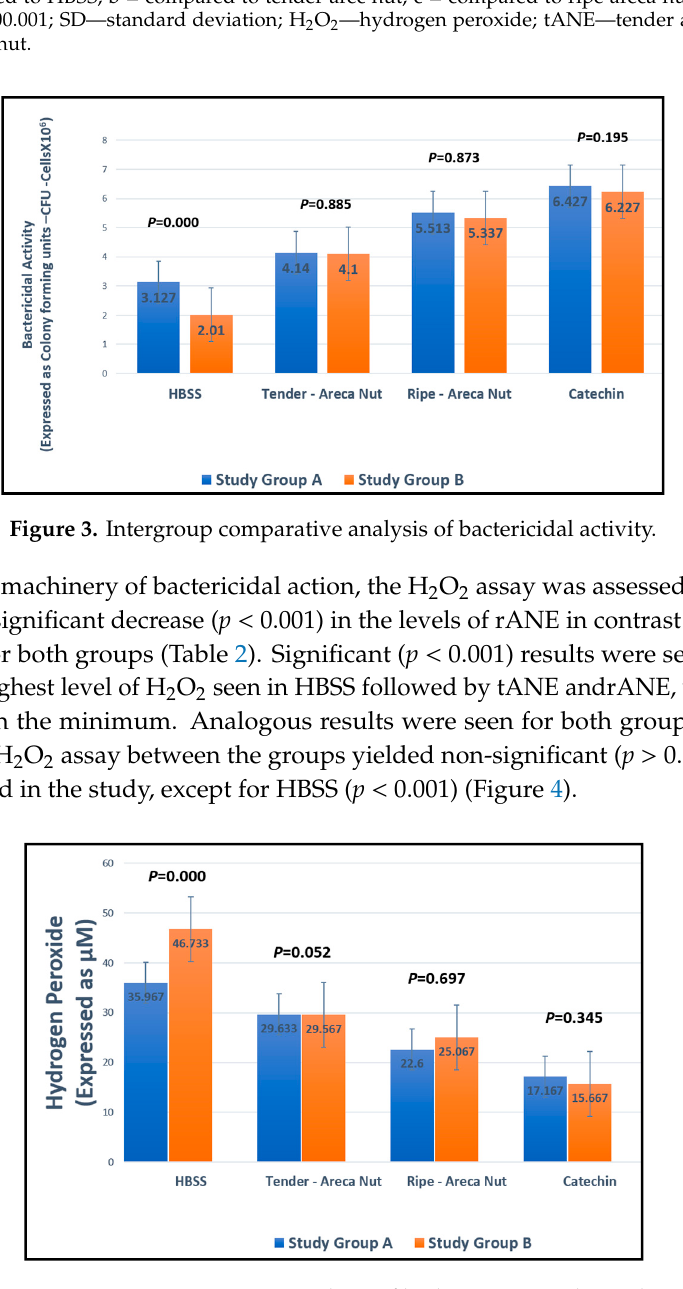
Figure 4. Intergroup comparative analysis of hydrogen peroxide production.